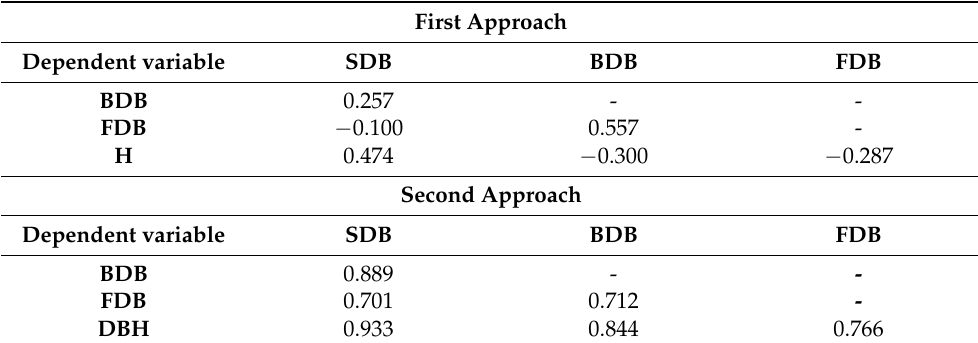
Table 5. Correlation between residual errors for both approaches of seemingly unrelated mixed- effects model system.